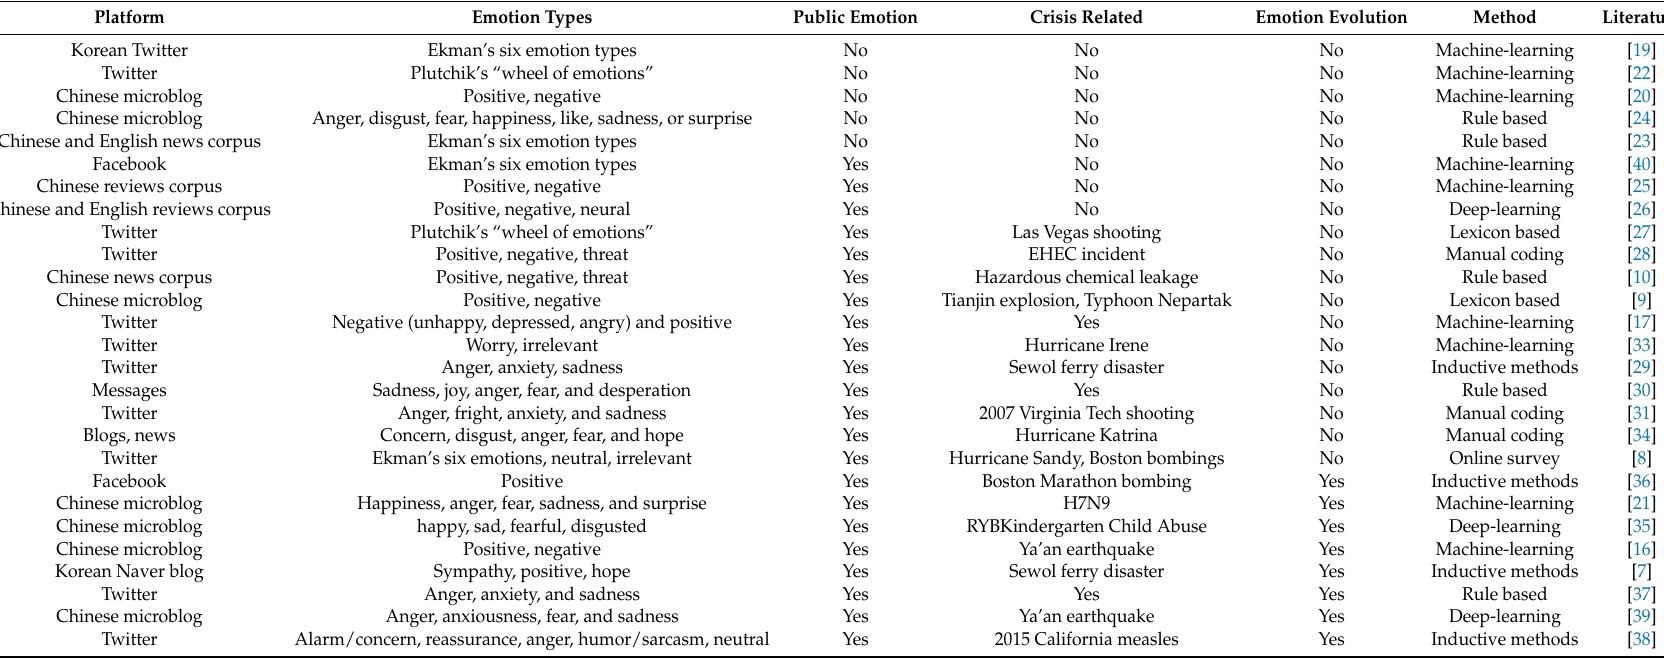
Table 1. Literature related to emotion analysis in social network